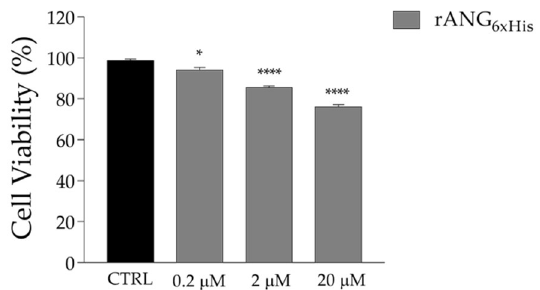
Figure 9 . HaCaT cells viability measured after the treatment of cells for 24 h with increasing doses of rANG 6xHis . Statistical analyses were carried out by using GraphPad Prism. Values are the means ± SEM of biological replicates (* p < 0.05, **** p < 0.0001) compared to the respective controls (one-way ANOVA, followed by Bonferroni’s post-test).